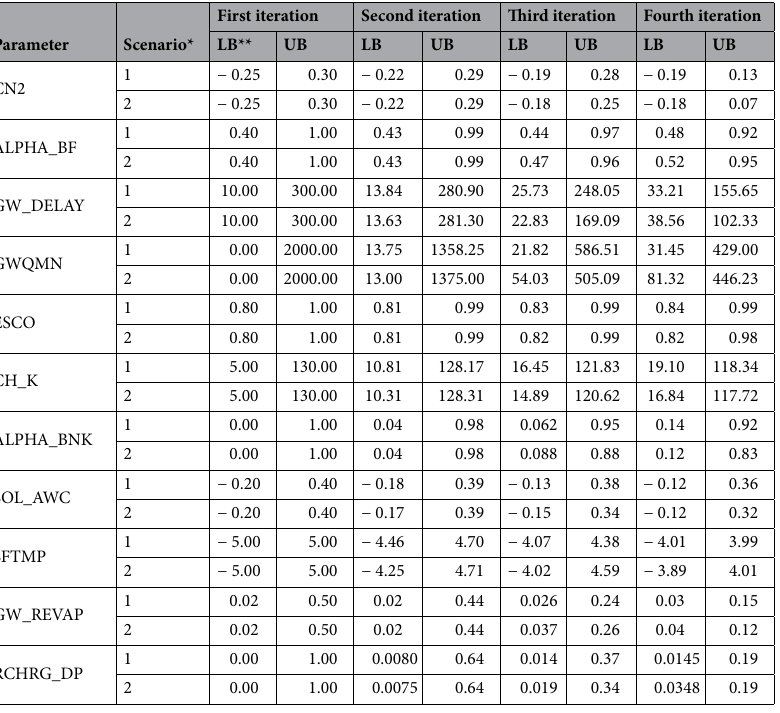
Table 4. Parameter range values of each iteration. *Scenarios: 1, simulations with one criterion; 2, simulations with two criteria. **LB: Lower bound; UB: Upper